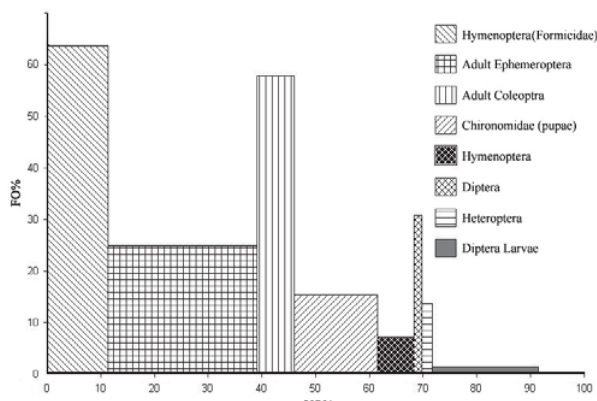
Fig. 3. Representation of the alimentary index (IAi), associat- ing relative frequency (FO%), and relative volume (VO%) of the main items in the diet of Thoracocharax stellatus of the upper rio Tocantins.